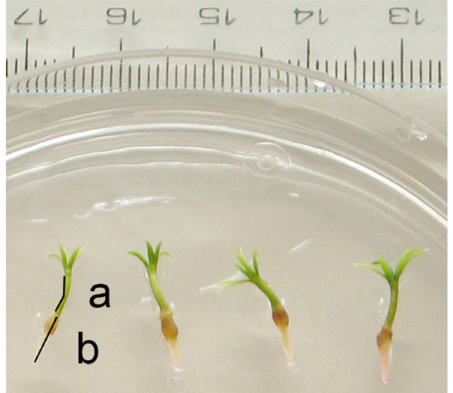
Figure 1. Norway spruce embryos after two weeks’ germination and the illustration of the measure- ment of the shoot ( a ) and root meristems ( b ). The ruler was for calibration of the ImageJ software, distance of the short lines is